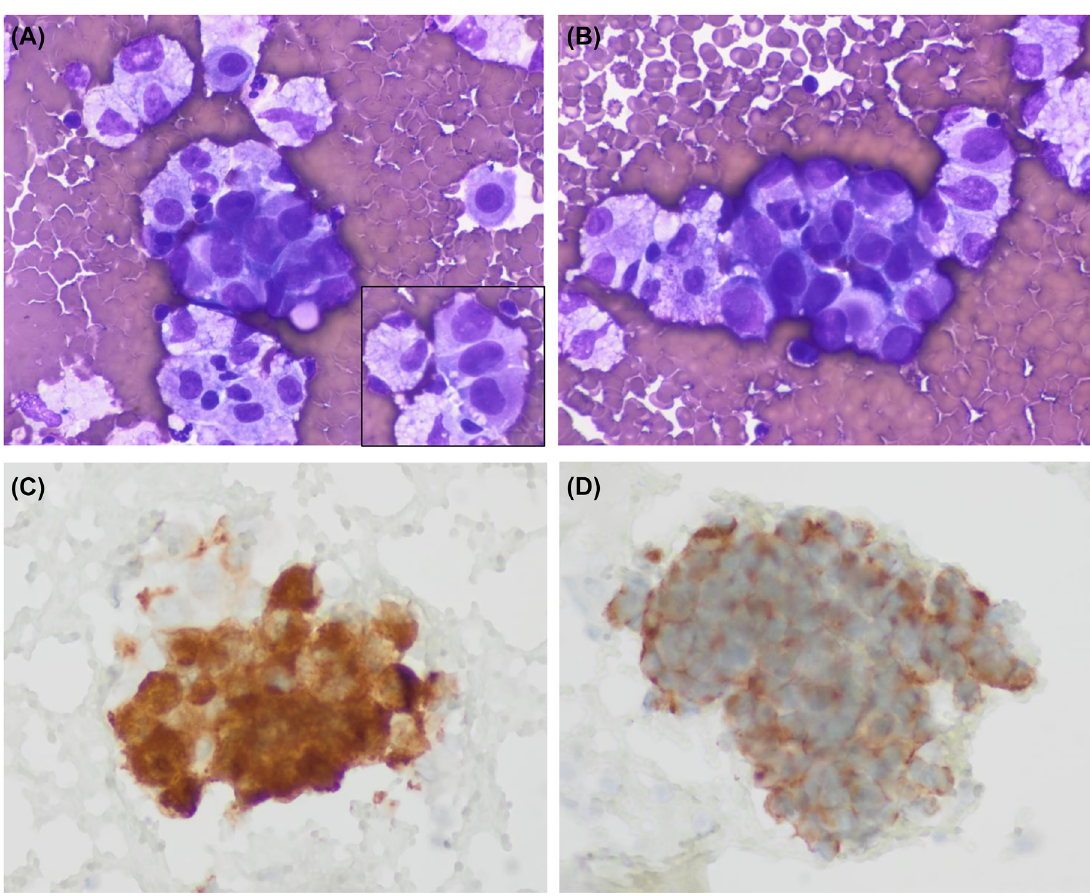
Figure 1: Cytologic images of the pleural effusion sample. (A, B) Medium size clusters of large neoplastic cells showing epithelioid morphology. Nuclei are largeand pleomorphic with no spindlecells. The inset of panel A showsa shortcord of tumoral cells separated by cell windows(Diff-Quik, × 600respectively).(C,D)Tumoralcellsshowingimmunoexpressionofc-kitandDOG1,respectively(immunoperoxidase).